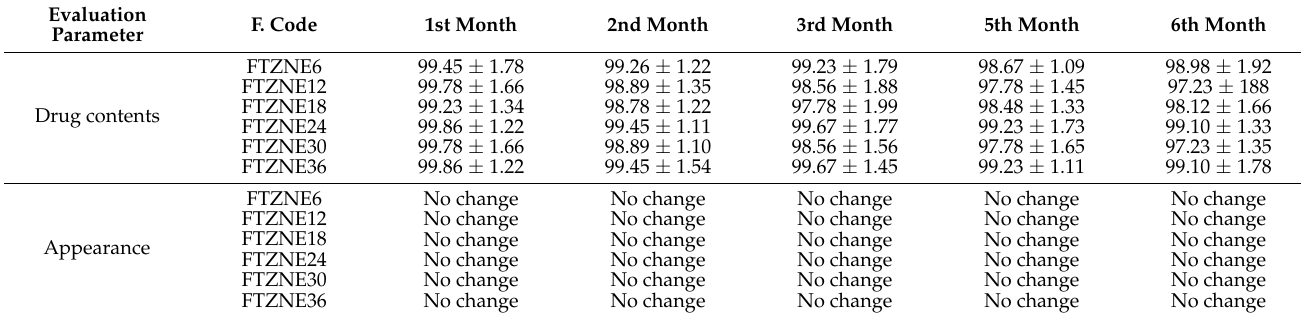
Table A4. Physical stability characteristics of Tizanidine, n = 3, mean ± S.D.